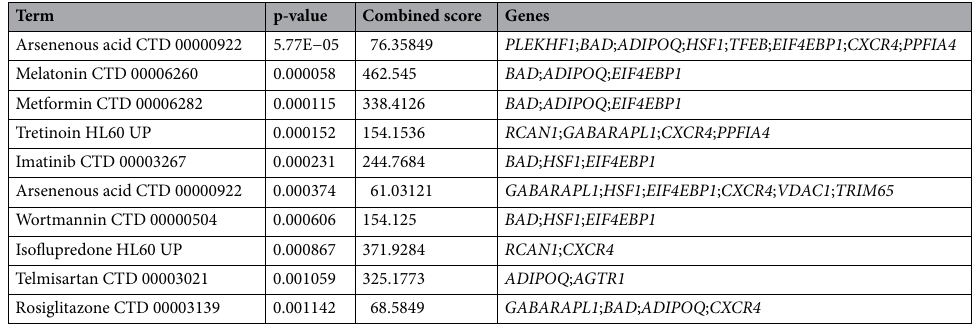
Table 3. Drugs of choice for dilated cardiomyopathy.